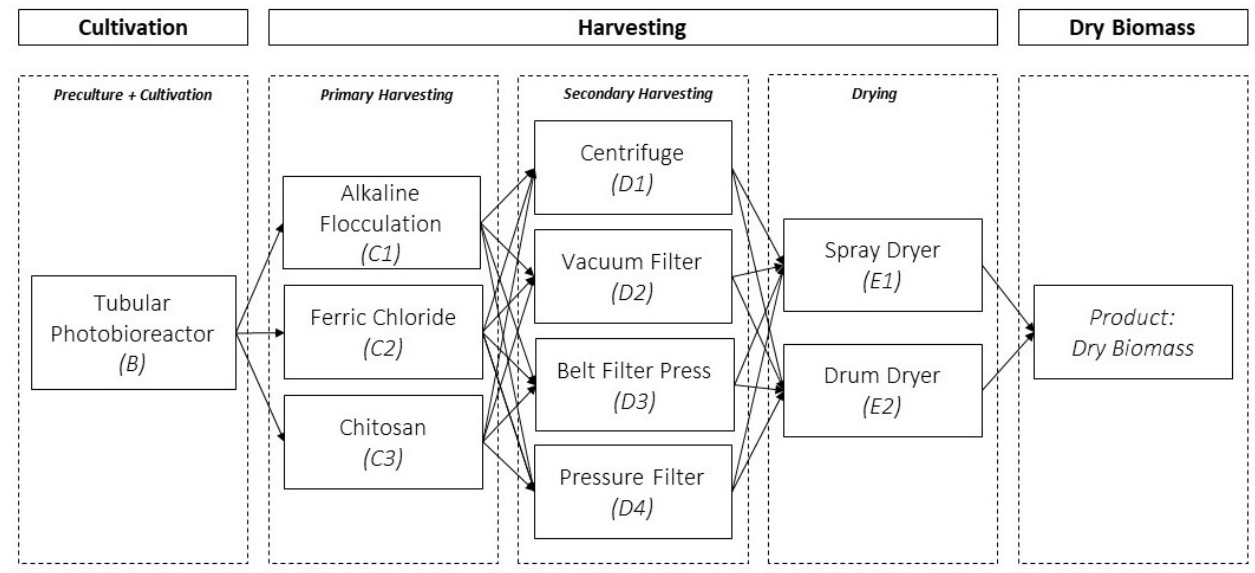
Figure 1. Summary of technologies included in the different process stages to produce microalgae biomass. Adapted from [56]. Table 2. Technological scenarios to produce dry microalgae biomass. Adapted from [56]. No. Scenario